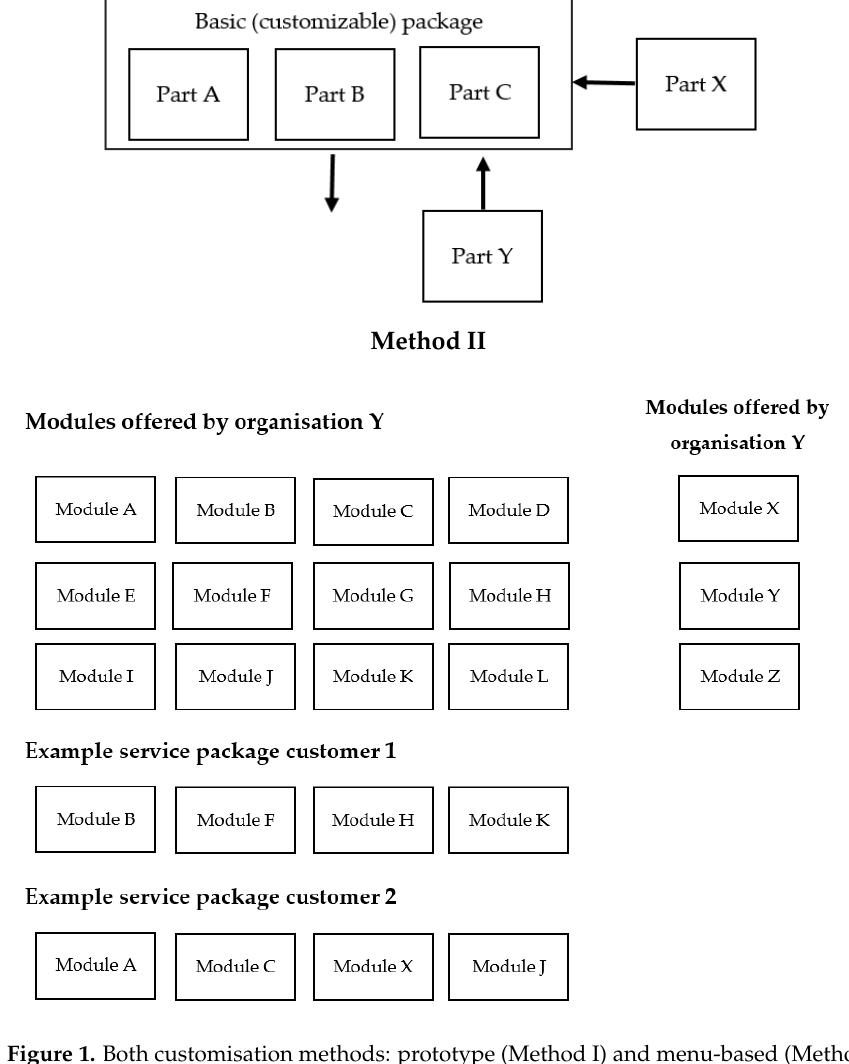
Figure 1. Both customisation methods: prototype (Method I) and menu-based (Method II).